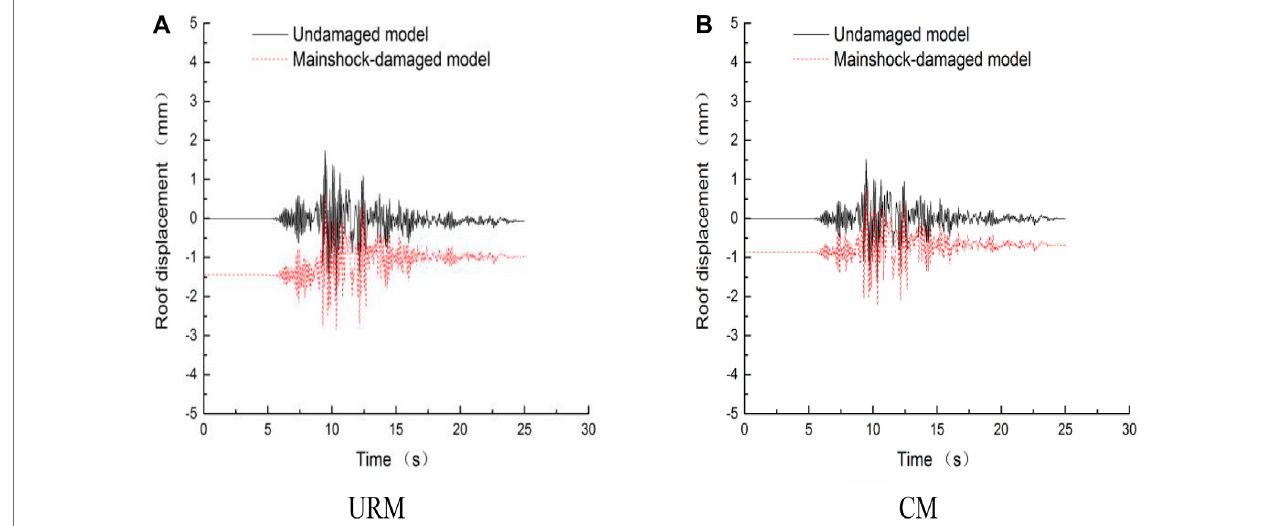
FIGURE6| Comparisonofroofdisplacementtime-historycurvesoftheundamagedandmainshock-damagedURMand CMmodelsunderaftershock(LOS-000, PGAMS (cid:2) 0.411 g, δ (cid:2) 0.6). (A) URM. (B) CM.